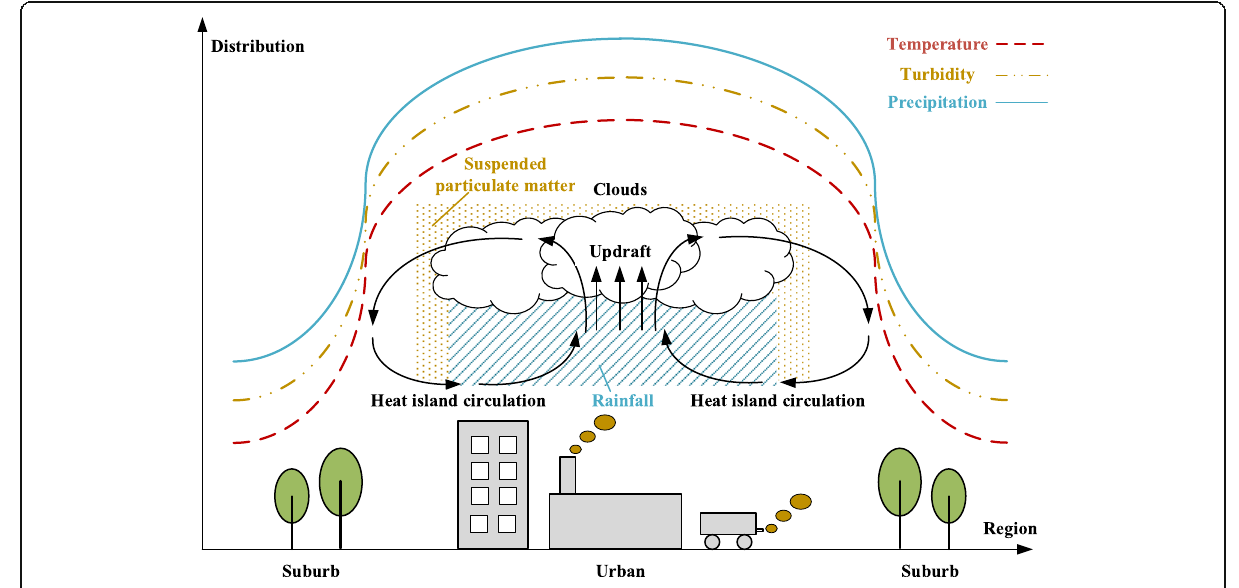
Fig. 4 A schematic diagram of multiple island effects of urbanization on